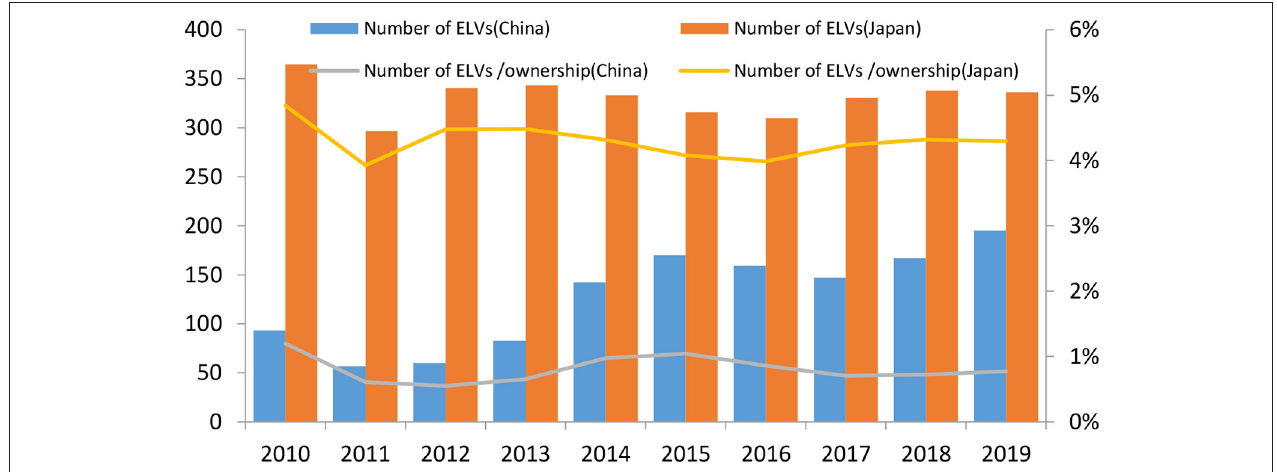
FIGURE 1 | Comparison of ELV recycling scale in China and Japan (Unit: 10,000 vehicles).